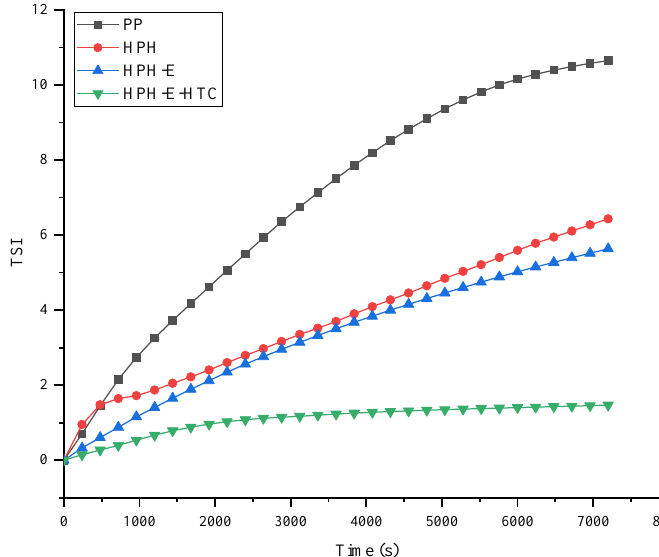
Figure 5. The instability index of peanut protein (PP), high pressure homogenized protein (HPH), high pressure homogenized and enzyme treated protein (HPH-E), and HPH-E-hydrothermally cooked (HPH-E-HTC) protein as a function of time.